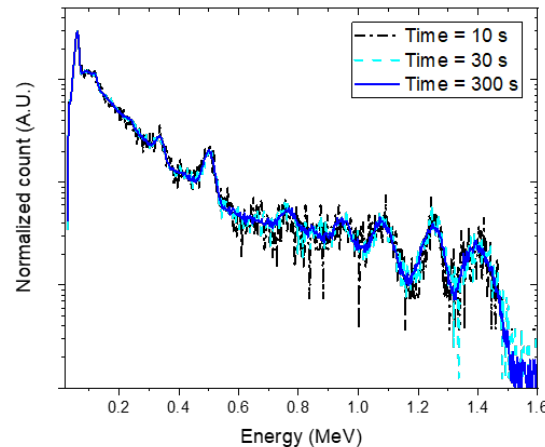
Figure 10. Experimental spectra with different acquisition times of 10 s (black dash-dotted line), 30 s (sky-blue dashed line), and 300 s (blue solid line) for the following radioisotopes buried in sand: Na-22, 10 cm; Am-241, 3 cm; and Eu-152, 8 cm. Obtained spectra were normalized to the total count over the energies of interest for comparison.